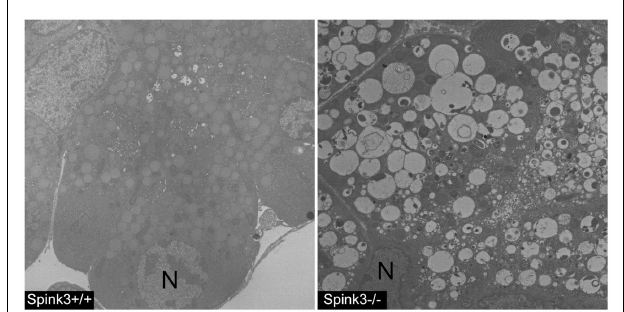
FIGURE 2 |The pancreatic acinar cells of Spink3 deficient mice. Many vacuoles, autophagosomes, are appeared in Spink3 deficient pancreatic acinar cells (Right panel). N, nucleus of the acinar